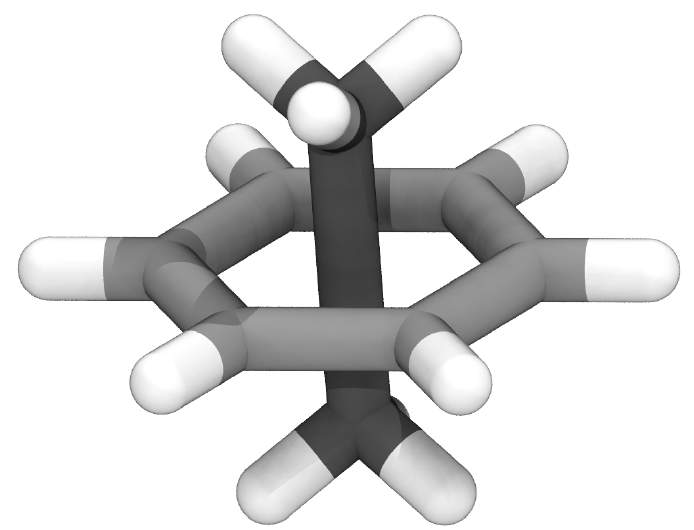
Figure 1. Example structure for ethane (darker carbons) piercing benzene (lighter carbons), high- lighting the unphysical geometry with the extended carbon-carbon bond that is a local minimum in classical MD force